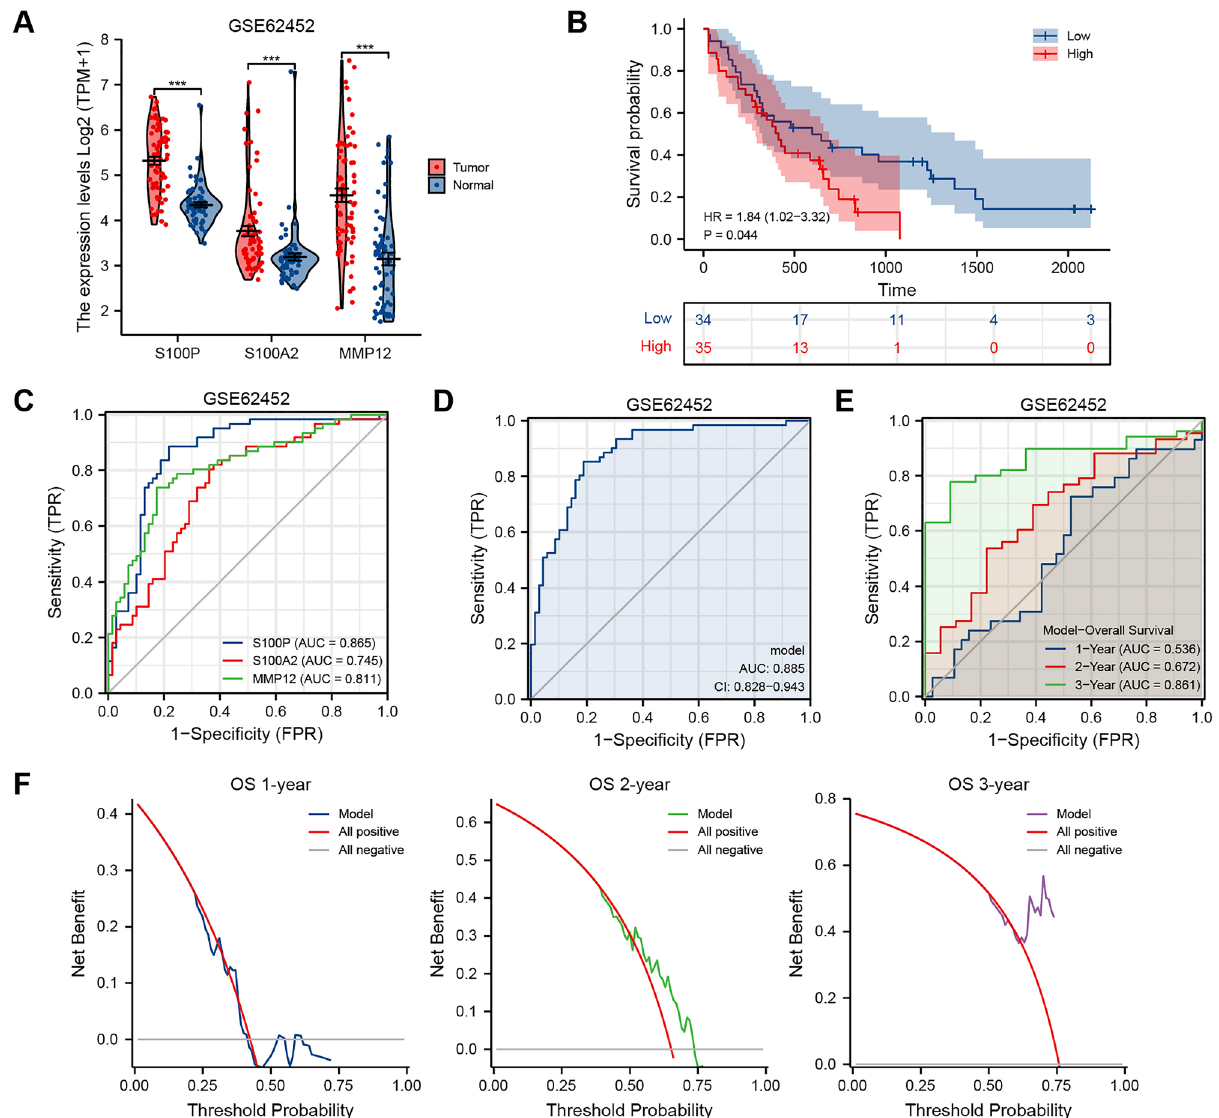
Figure 7. Validation of PAAD-IRGS with GSE62452. ( A ) Expression level of 3 IRGs in GSE62452 cohort; ( B ) Kaplan–Meier curves show a better OS in the low-risk group than the high-risk group; ( C ) diagnostic value of 3 IRGs for PAAD patients in GSE62452 cohort; ( D ) diagnostic value of PAAD-IRGS in GSE62452 cohort; ( E ) time-dependent ROC curve analysis of the PAAD-IRGS at 1, 2, and 3 years in GSE62452 cohort; ( F ) decision curve analysis for evaluating the net benefits of PAAD-IRGS in GSE62452 cohort. * P < 0.05, ** P < 0.01, *** P < gression of various tumors 49,50 . Thus, we must investigate any relationship between PAAD-IRGS and TIICs in PAAD. We used a lollipop plot to perform the correlation analysis of 24 immune-related cells (Fig. 11A). There was a significant positive correlation between PAAD-IRGS and NK CD56bright cells (r = 0.333, P < 0.001) and Th2 cells (r = 0.367, P < 0.001) and negative correlation with plasmacytoid dendritic cells (pDC) (r = −0.348, P < 0.001) and follicular helper T cell (TFH) (r = -0.344, P < 0.001). However, only B cell, CD4+ T cell and NK cell infiltration levels were correlated with OS of PAAD patients. Patients with high B cell (HR = 0.776, P = 0.0147) or NK cell (HR = 0.788, P = 0.0226) infiltration level had a better OS, while high CD4+ T cell + Th2 cell infiltra- tion level associated with worse OS (HR = 1.36, P = 0.00337) (Fig. 11B). There was no statistically significant difference between high-risk and low-risk groups in patients with PD-1 blocker/CTLA4 blocker/CTLA4&PD-1 blocker or without immune-blocker (Fig. 11C). As a supplement, we conducted correlation analysis between immunomodulators and PAAD-IRGS, which were visualized as heatmaps (Figs. 12A, 13A, 14A). For immune-inhibitors, PAAD-IRGS had positive correla- tion with TGFB1 (r = 0.372, P < 0.001), LGALS9 (r = 0.674, P < 0.001), IL10RB (r = 0.555, P < 0.001) and CD274 (r = 0.227, P = 0.002), negative correlation with KDR (r = −0.330, P < 0.001), CD160 (r = −0.358, P < 0.001), BTLA (r = −0.224, P = 0.003) and ADORA2A (r = −0.243, P = 0.001) (Fig. 12B). For (MHC) molecule, HLA-B (r = 0.271,